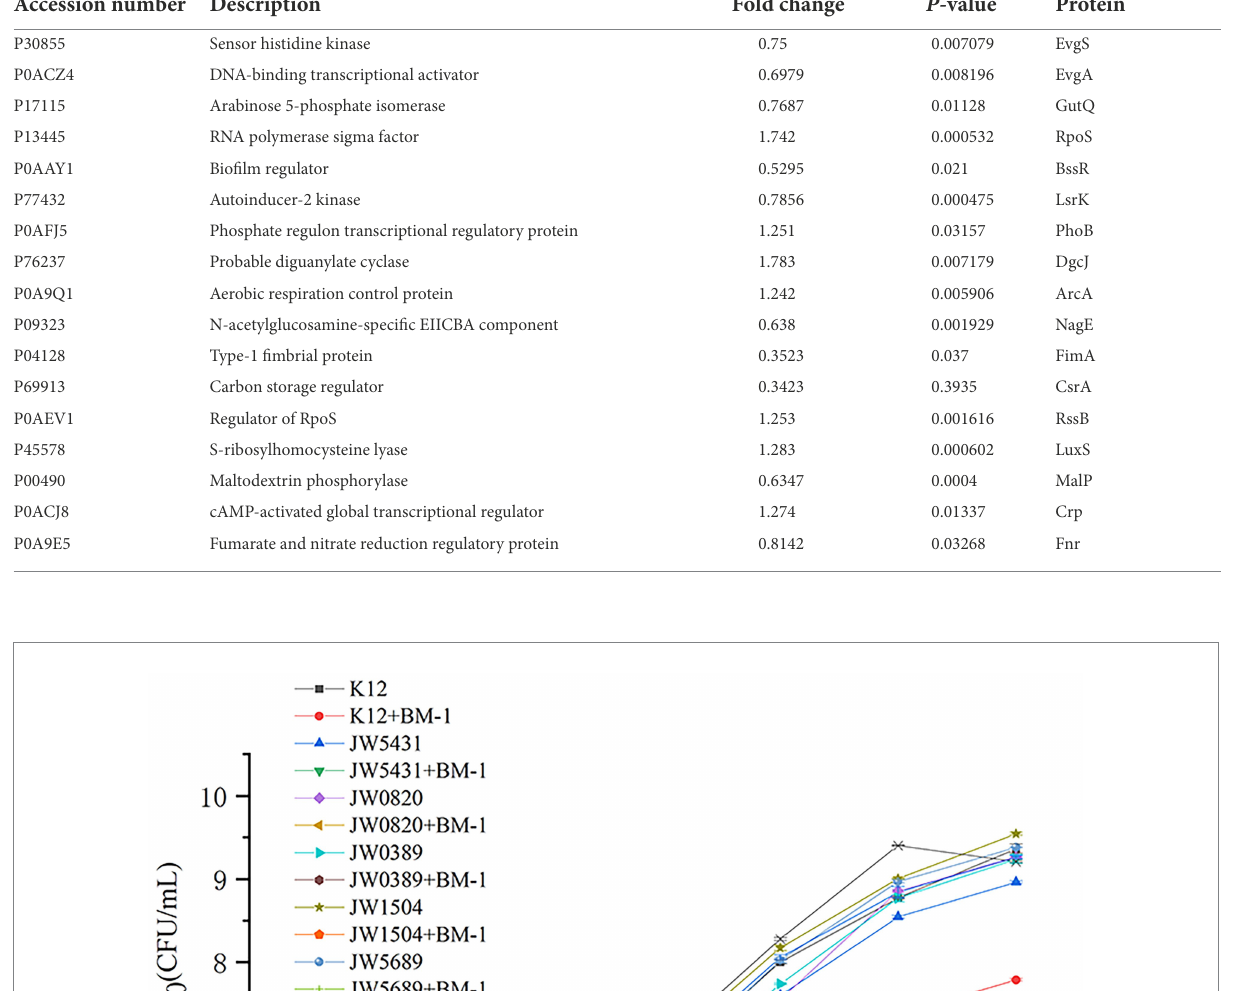
TABLE 3 Differentially expressed proteins related to biofilm formation in Escherichia coli JW5917.